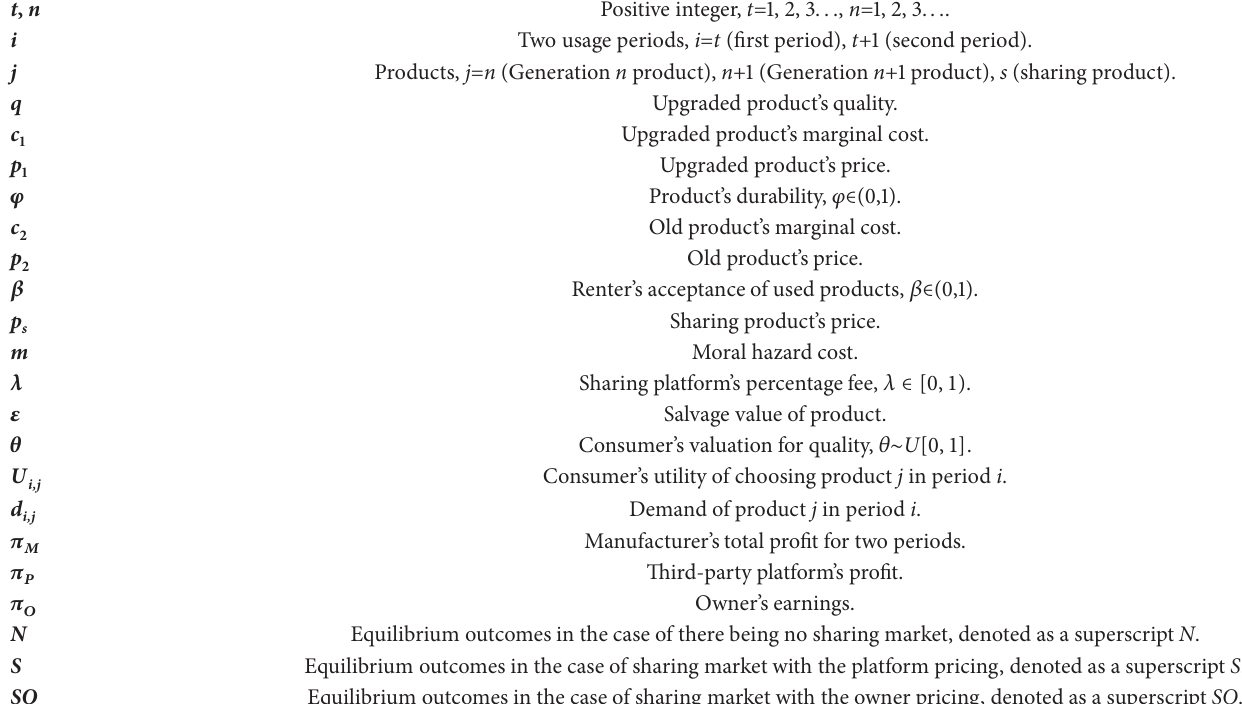
Table 1: Notations and definitions used in the